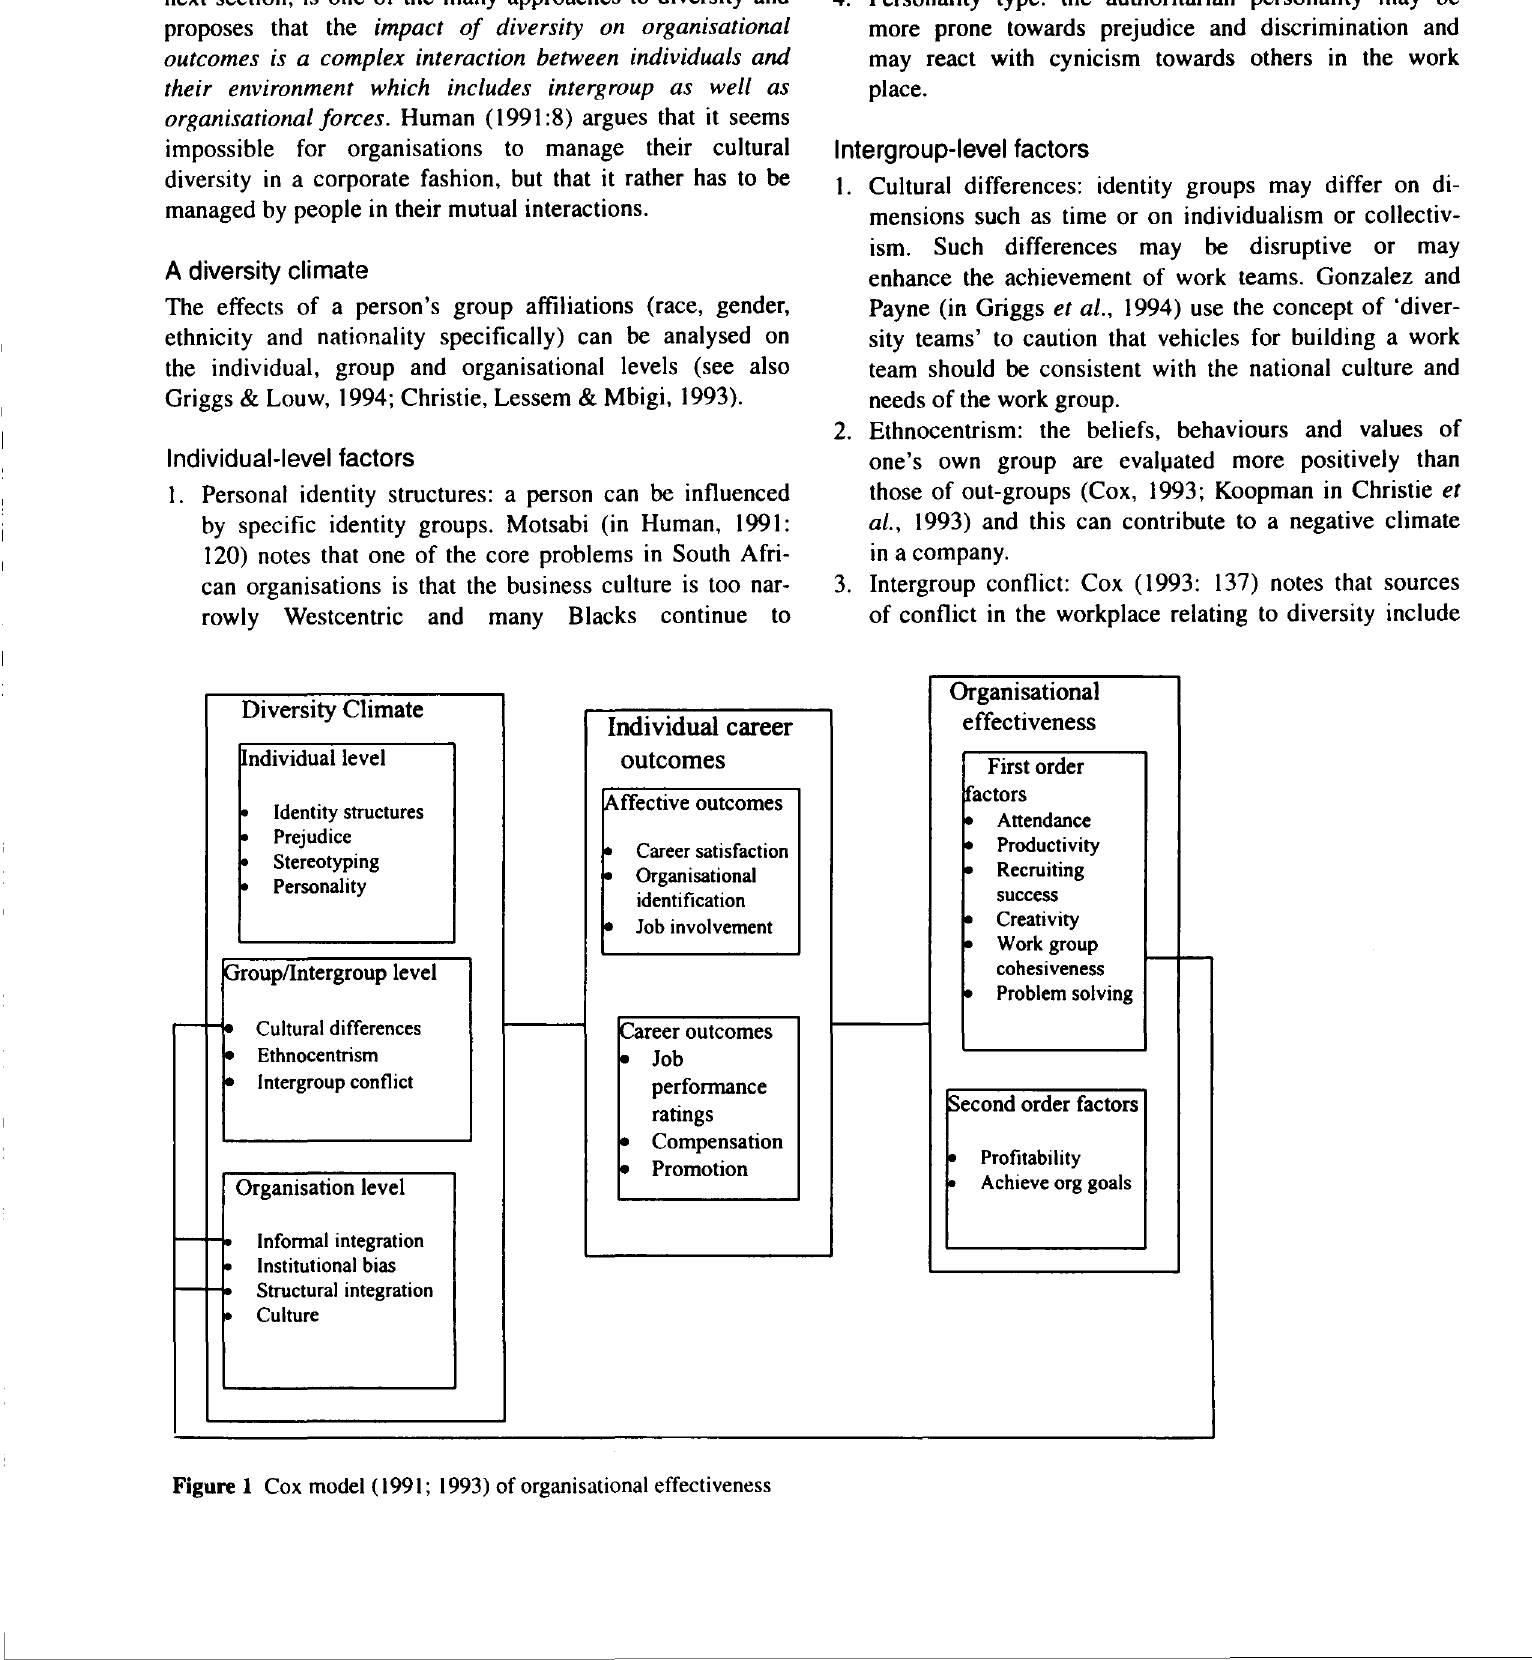
Figure 1 Cox model (1991; 1993) of organisational